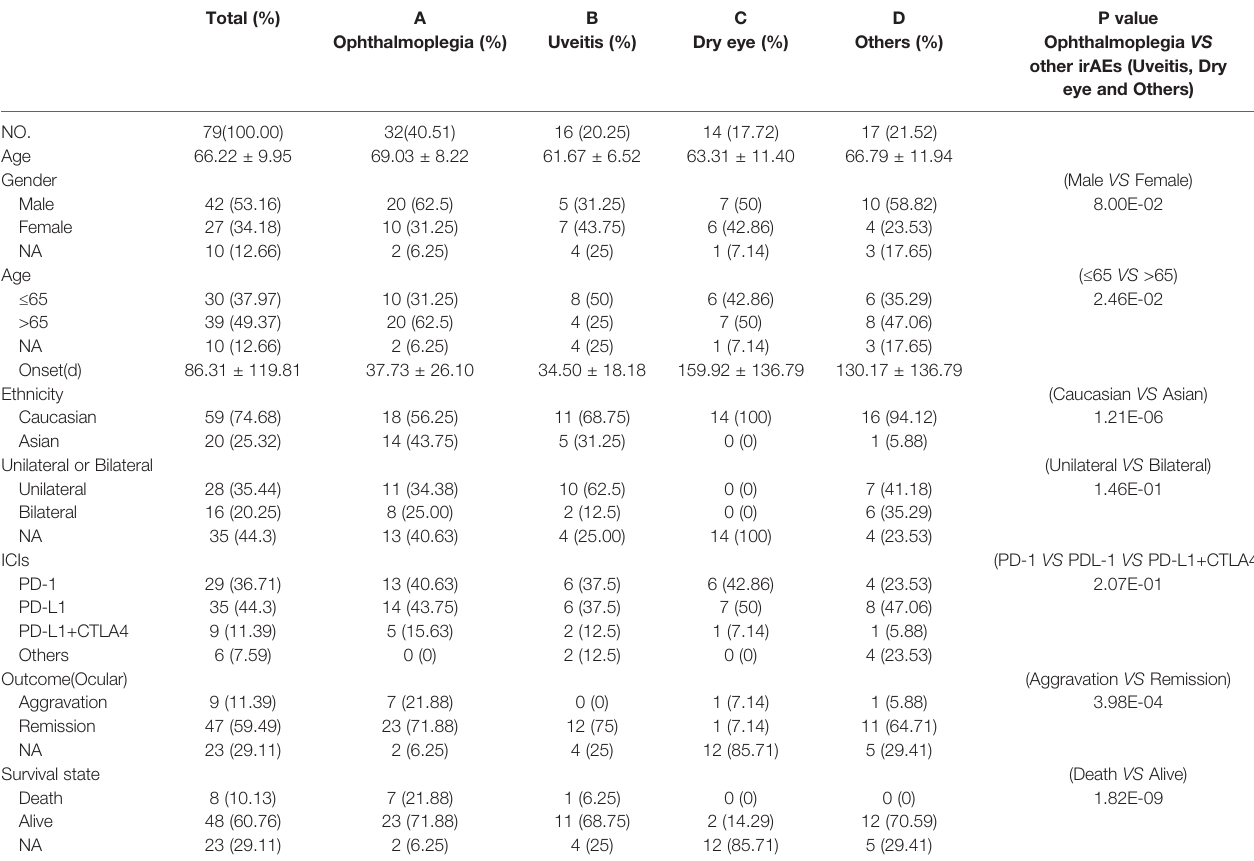
TABLE 2 | Comparison of the ophthalmoplegia, uveitis and other ocular irAEs secondary to ICIs in lung cancer. Total (%) A B C D P value Ophthalmoplegia (%) Uveitis (%) Dry eye (%) Others (%) Ophthalmoplegia VS